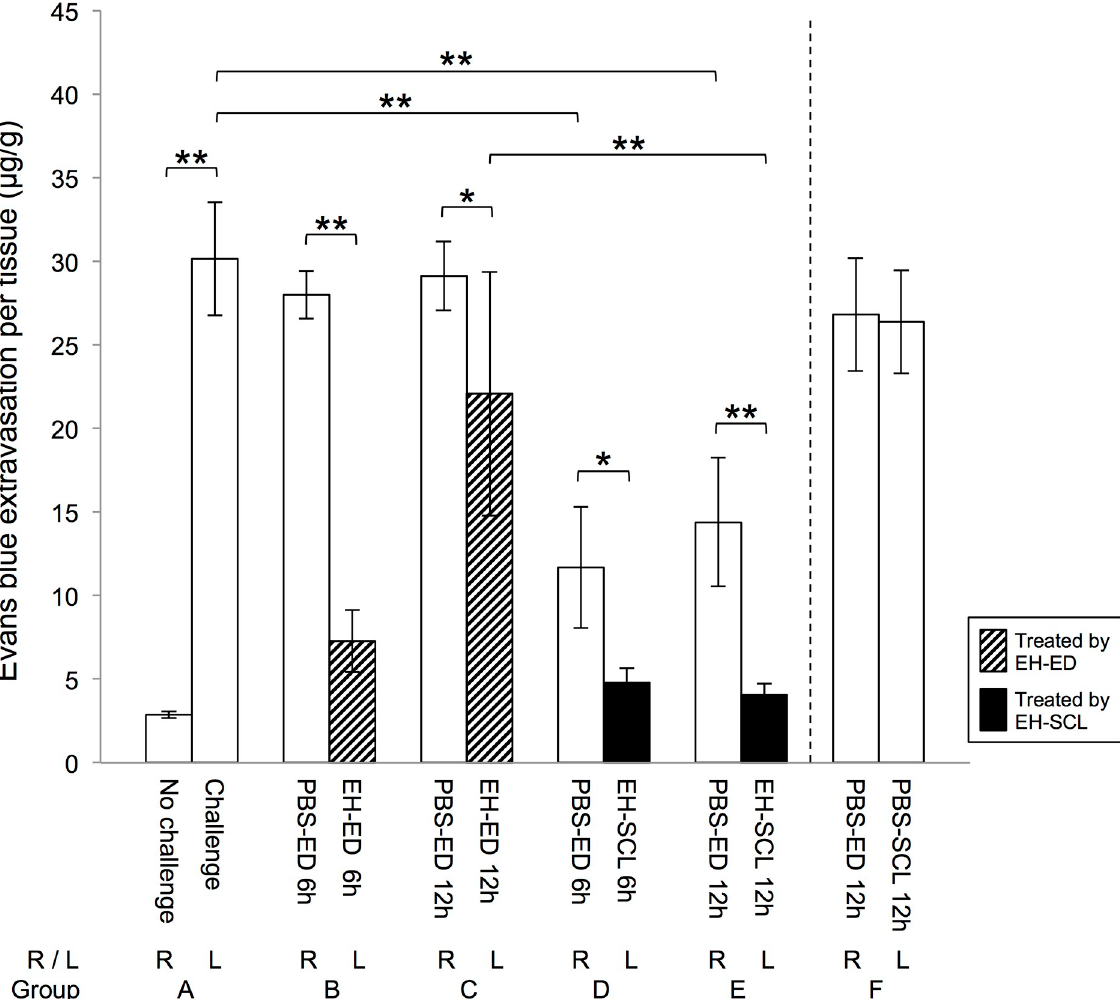
Fig 7. Evans blue (EB) extravasation per tissue. The extravasation of EB was significantly inhibited in the eyes in which epinastine hydrochloride (EH) was administered in the form of either eye drops or soft contact lens. Twelve hours after each treatment, EH-SCLs made with a 0.005% solution of EH inhibited EB extravasation significantly more compared with EH-EDs. Groups A to E, n = 6; for group F, n = 3. For groups A to E, the data were analyzed using one-way ANOVA and Tukey-Kramer test. � and �� indicate P < 0.05 and P < 0.01, respectively. PBS-ED: treated with phosphate-buffered saline eye drops, EH-ED: treated with epinastine hydrochloride eye drops, PBS-SCL: treated with a soft contact lens containing no epinastine hydrochloride, EH-SCL: treated with a soft contact lens made with a 0.005% solution of epinastine